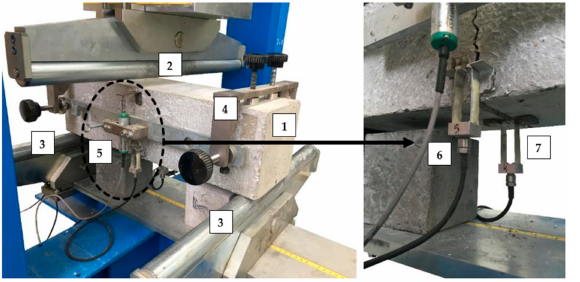
Figure 5. Picture of the sample during the three-point bending test: 1—sample; 2—loading roller; 3—supporting roller; 4—rigid frame to install LVDT; 5—LVDT to measure δ ; 6—clip gauge to measure CTOD; 7—clip gauge to measure